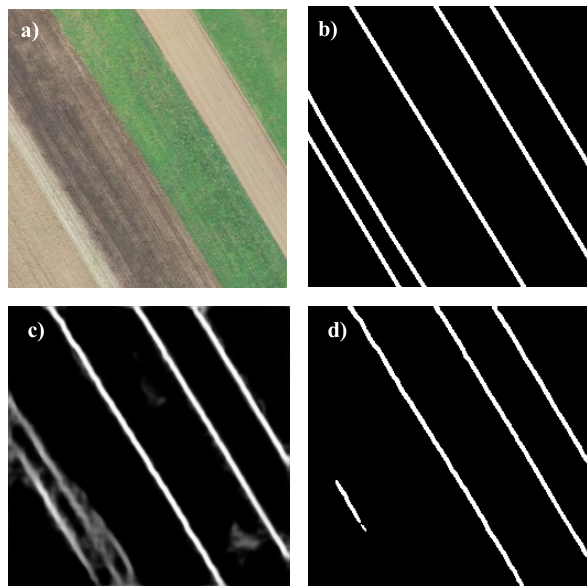
Figure 4. Predictions of the trained model based on U-Net. (a) Example 1 of tiled UAV image. (b) ground truth boundaries. (c)